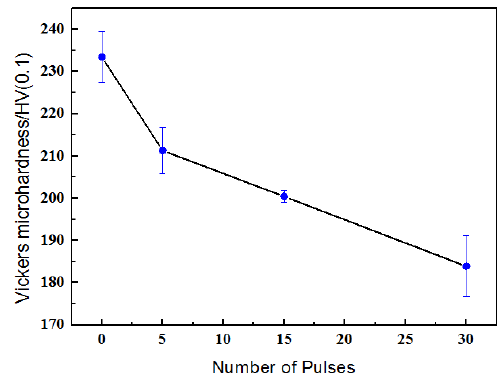
Figure 7: The change of microhardness for Zr-17Nb alloy surface before and after HCPEB